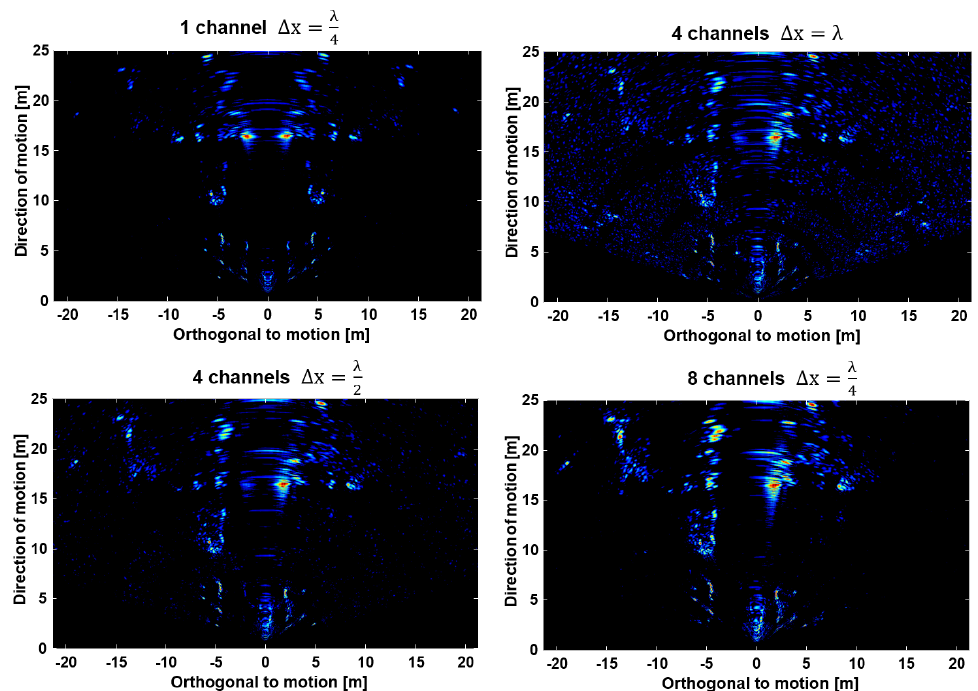
Figure 6. Forward SAR imaging using a number of channels ranging from 1 to 8 and at different pulse transmission rates. In all panels, the SAR sensor is placed at the origin (0, 0). Notice how the left/right ambiguity is suppressed using more